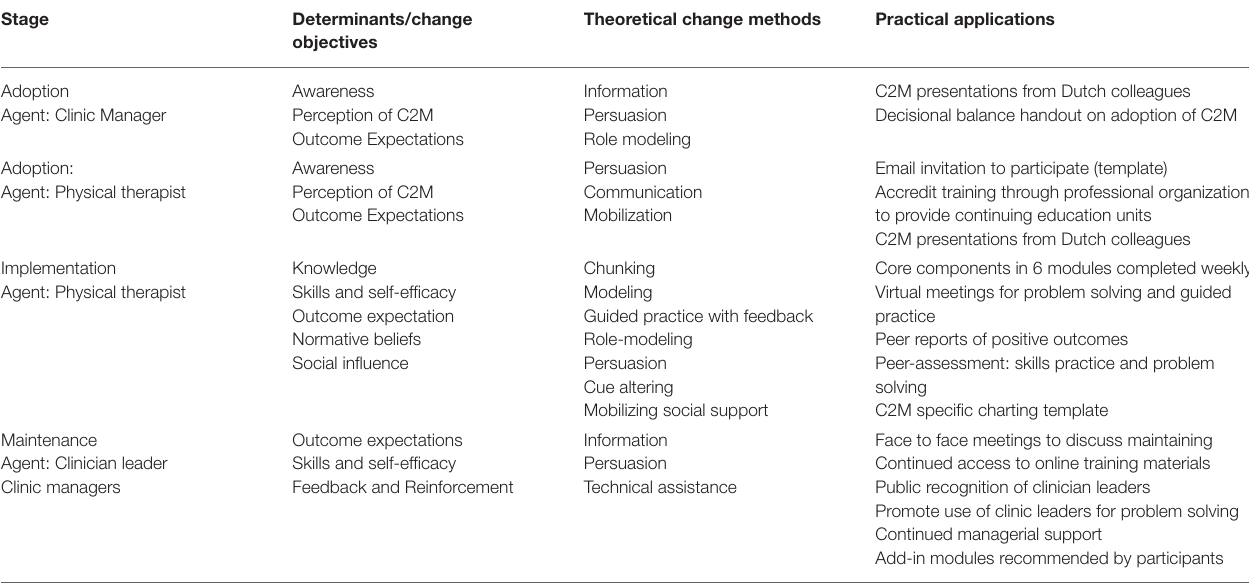
TABLE 5 | Coach2Move (C2M) implementation intervention plan.